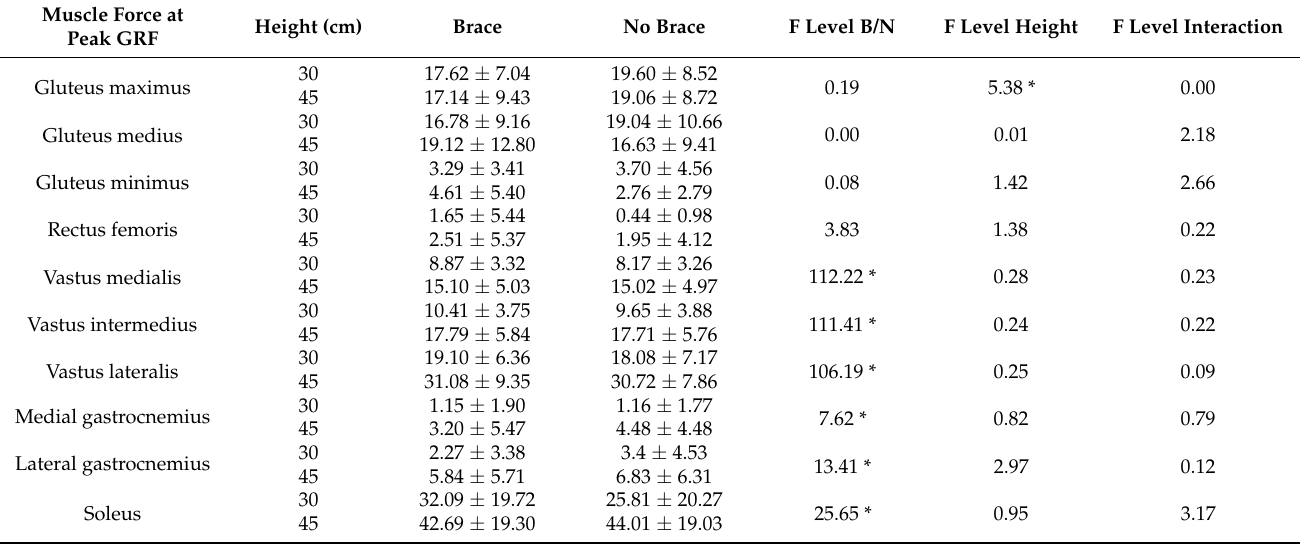
Table 1. Muscle force data (N/kg) during landing of the braced and non-braced participants at peak